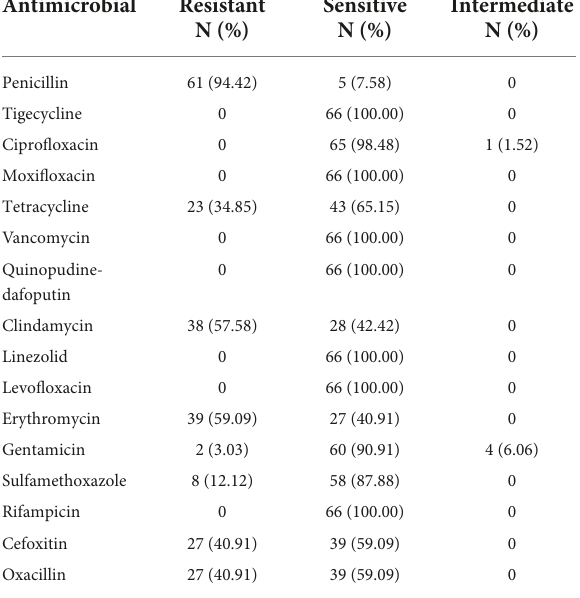
TABLE 3 Antimicrobial resistance profiles of 66 invasive Staphylococcus aureus strains.